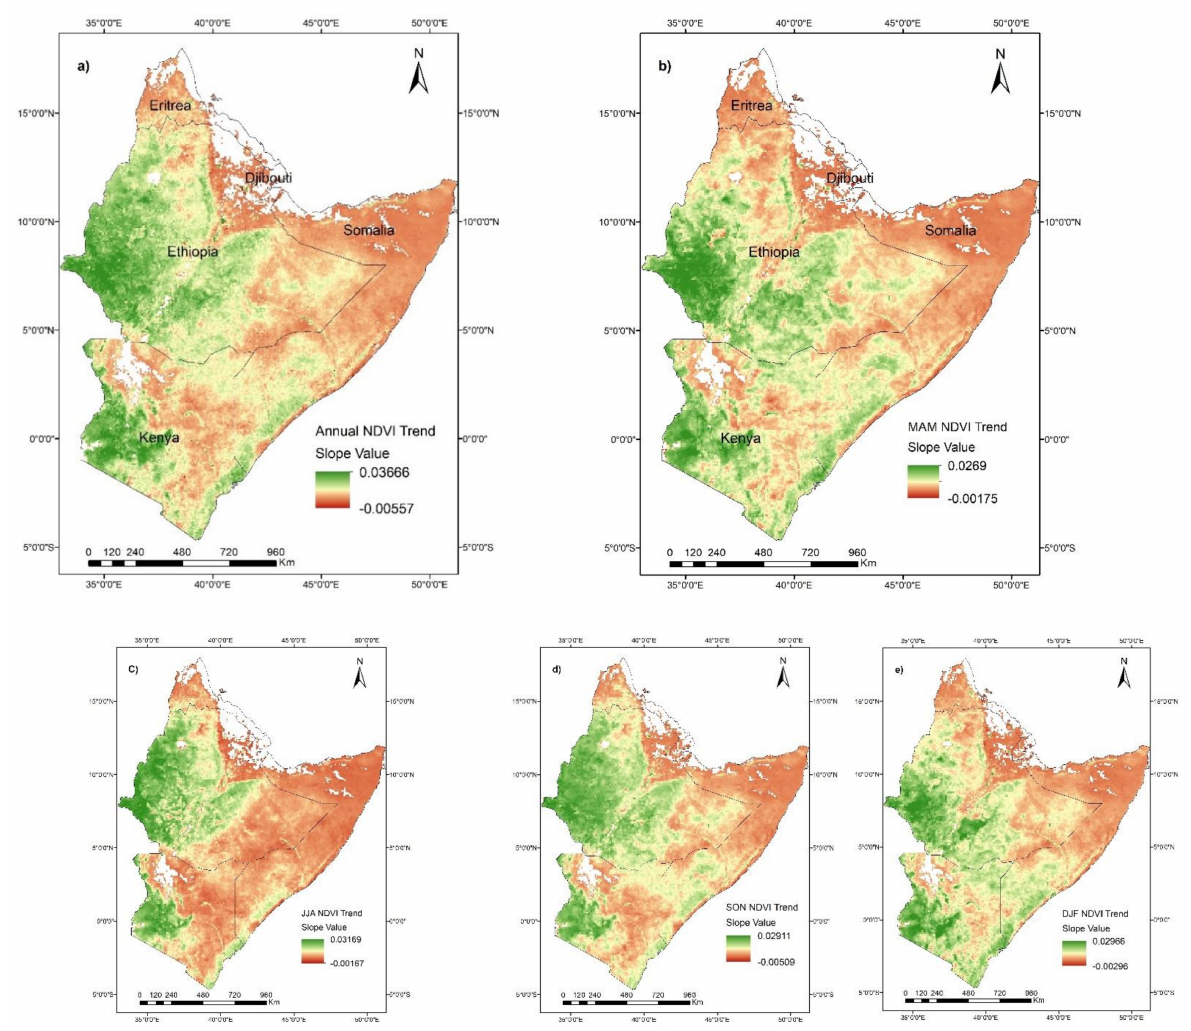
Figure 3. NDVI trends during 2000–2019 in the Horn of Africa. ( a ) Annual mean and ( b – e ) seasonal mean trends.